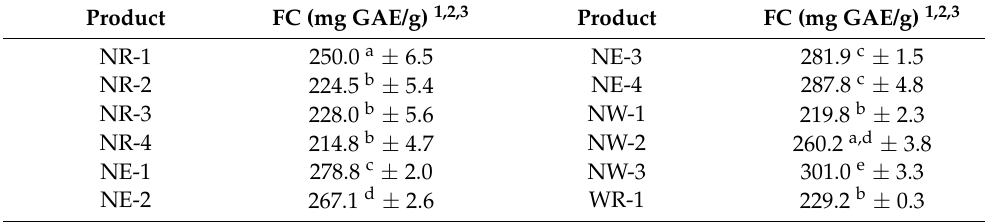
Table 4. Folin–Ciocalteu (FC) reducing capacity results for extracts of C. longa